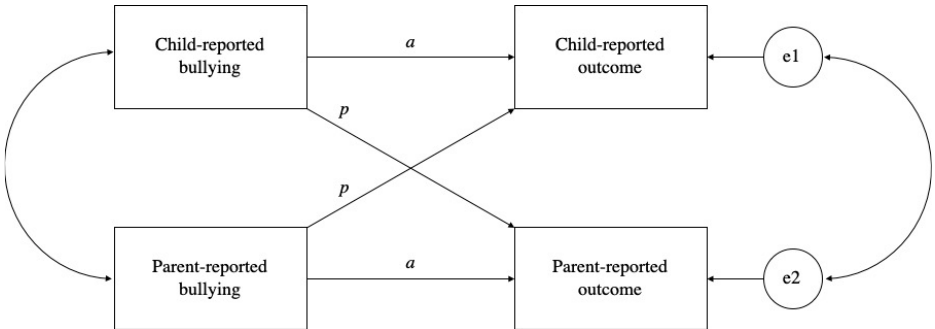
Figure 1. Conceptual depiction of the actor-partner interdependence model (APIM) of the impact of child bullying on child outcomes. child bullying on child